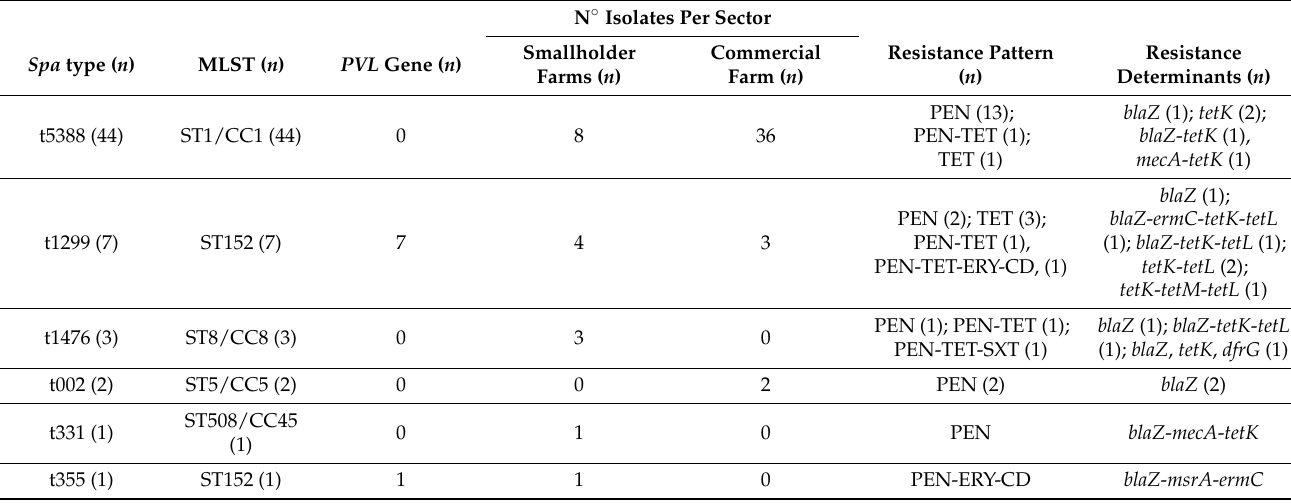
Table 2. Clonal relatedness and resistance profile of S. aureus isolated from raw milk in dairy cows in Manhiça District, southern